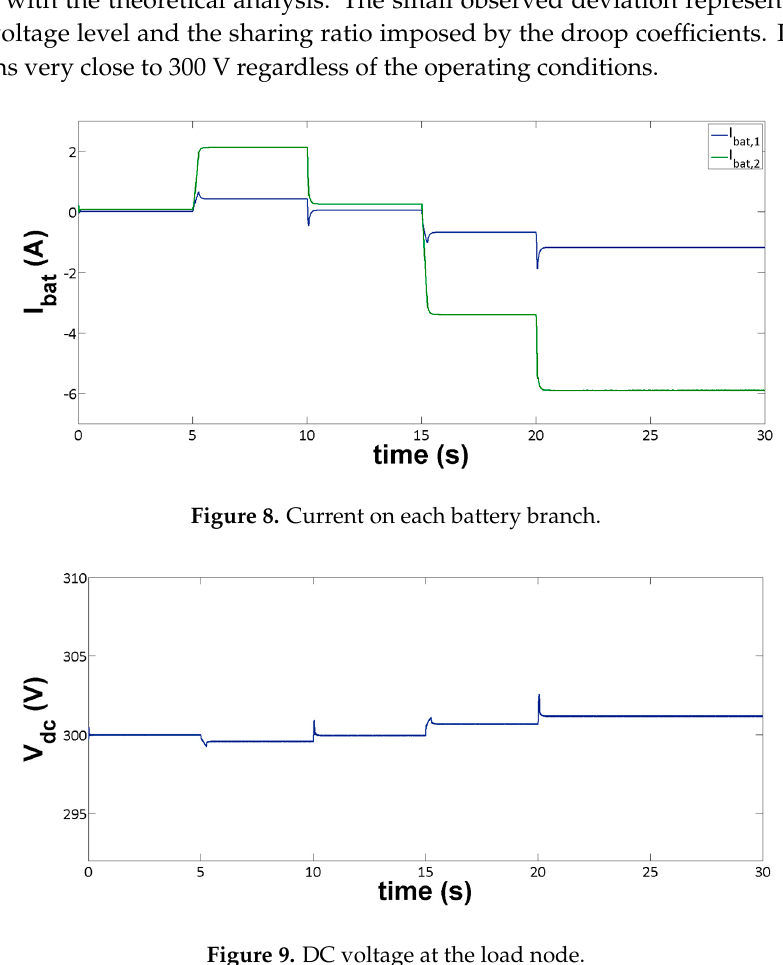
Figure 9. DC voltage at the load node.